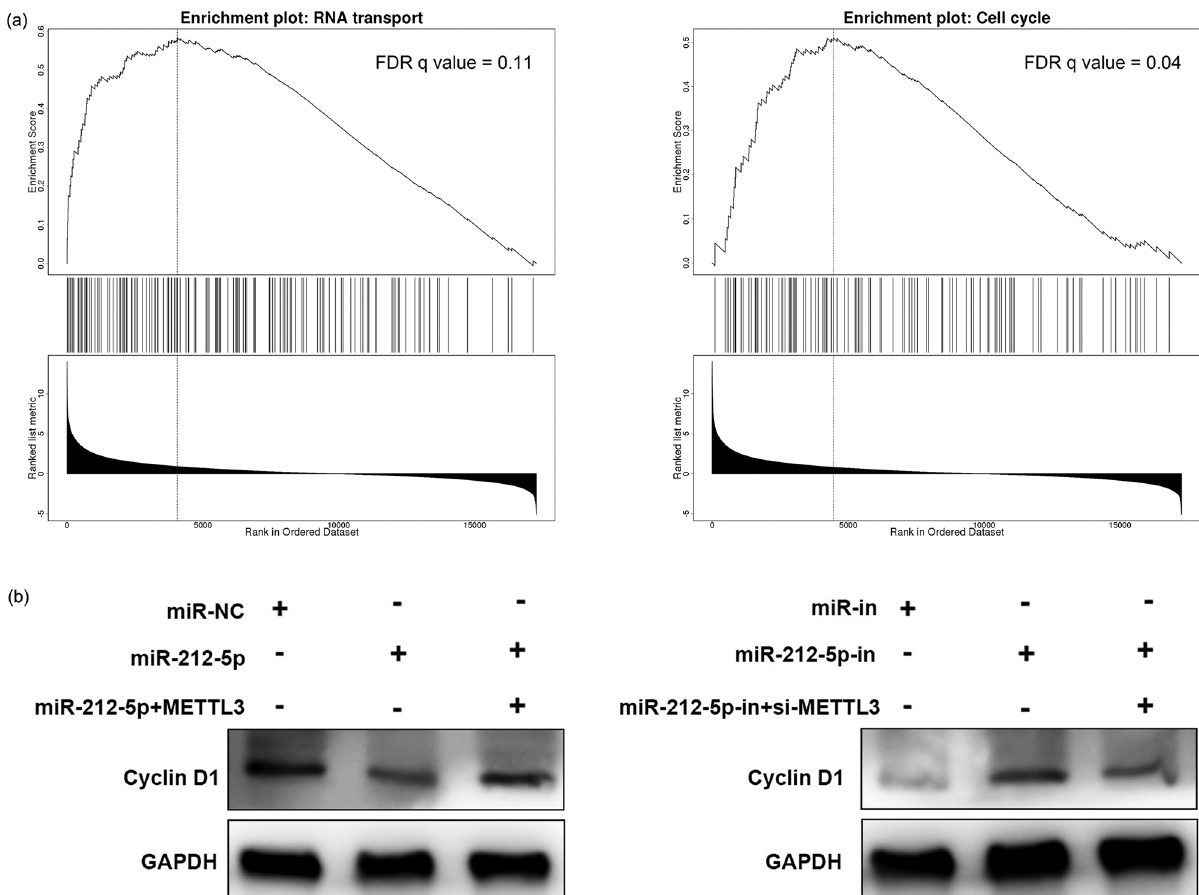
Figure 5: METTL3 activates the DNA replication, cell cycle signaling pathway. ( a ) Signaling pathway enrichment analysis was conducted through GSEA. ( b ) miR - 212 - 5p and METTL3 overexpression plasmids were co - transfected into 6 - 10B cells, and miR - 212 - 5p - in and si - METTL3 were transfected into 5 - 8F cells. The expression of Cyclin D1 was analyzed by western